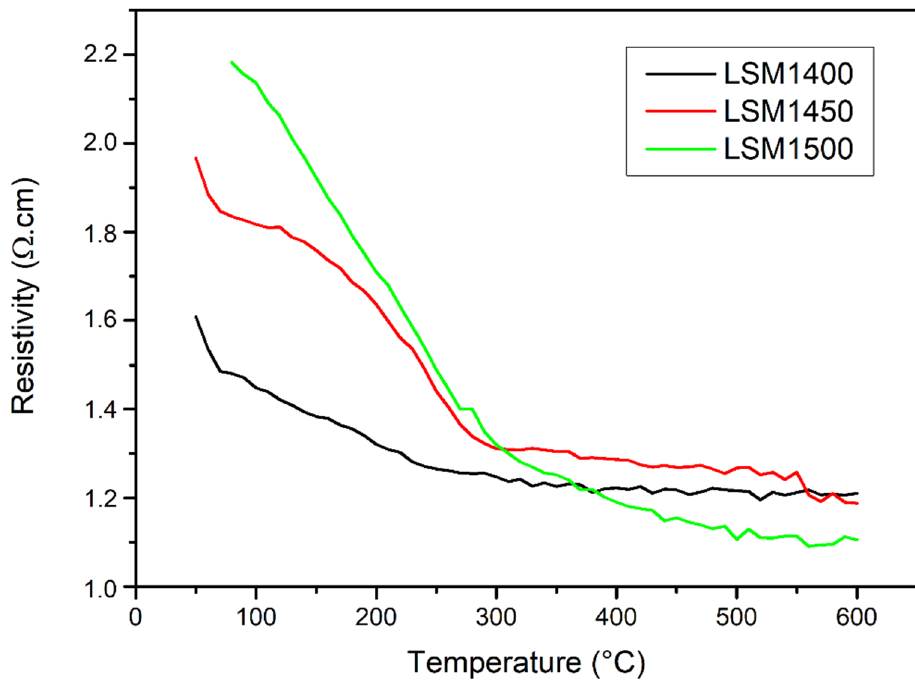
Figure 3. Variation in resistivity with the temperature of the calcined La 0.6 Sr 0.4 MnO 3 samples.